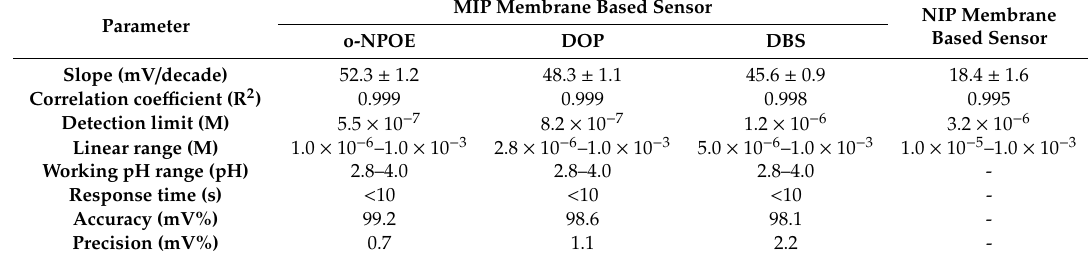
Table 1. Response characteristics of the proposed cytarabine sensors.